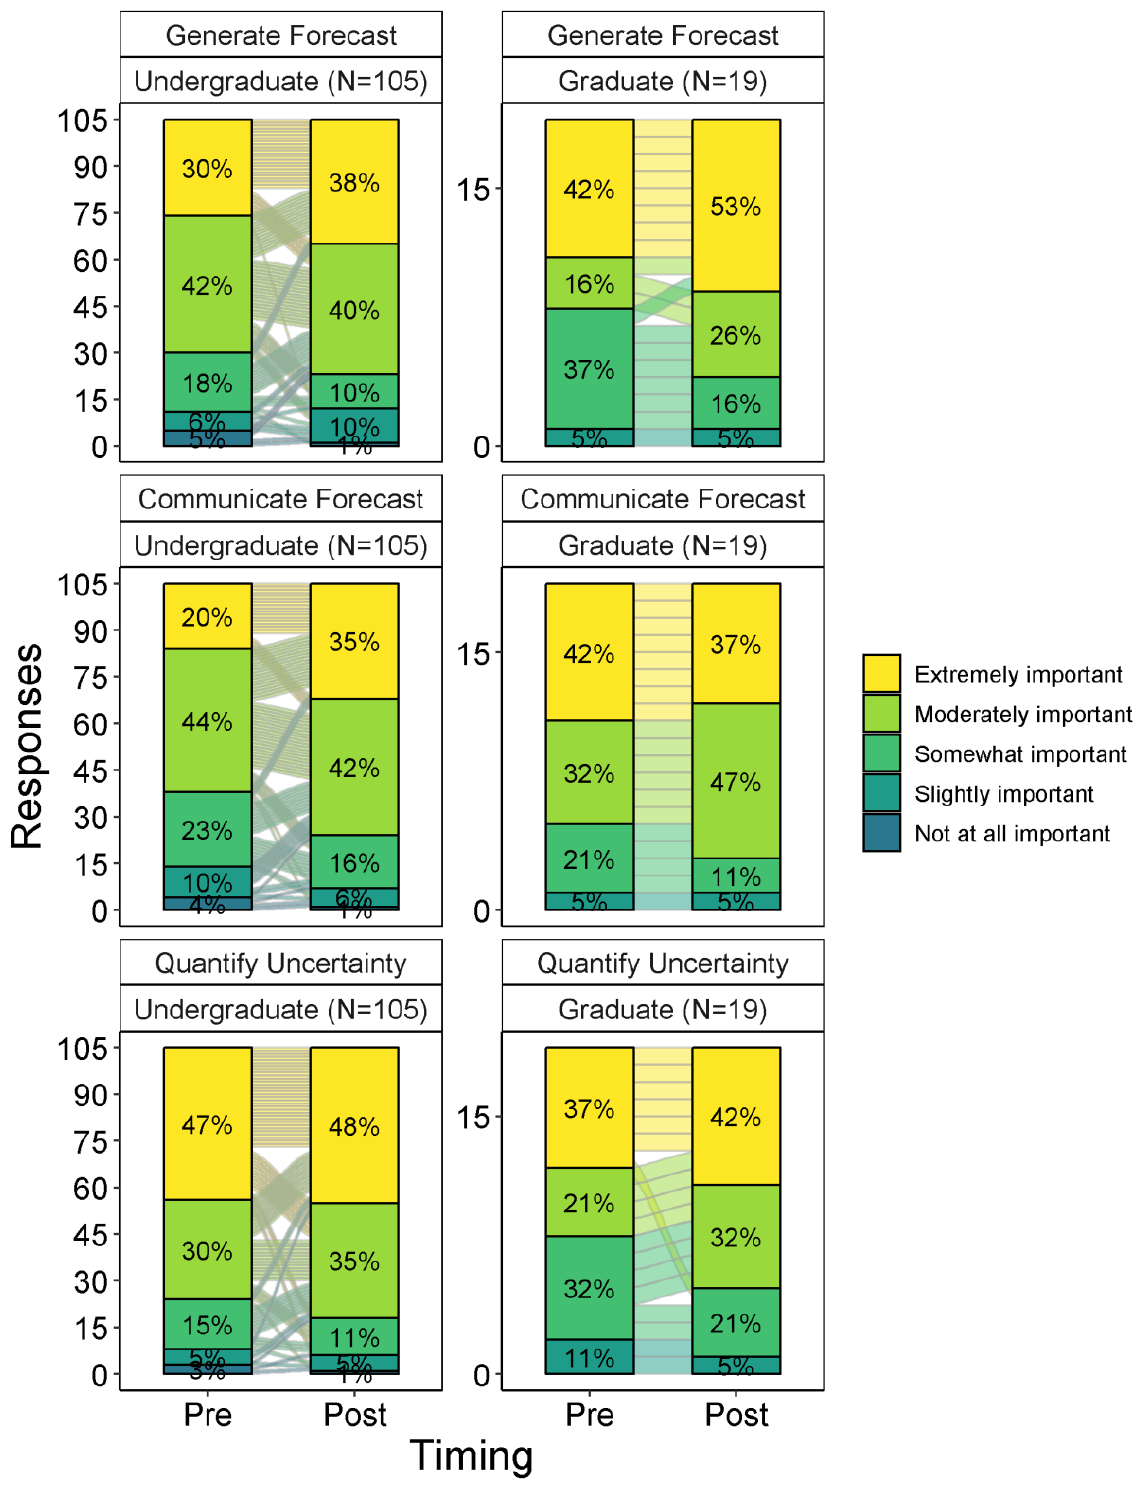
Figure 7. Students’ self-reported assessment of the importance of generating a forecast (left column), communicating a forecast (middle column), and quantifying uncertainty (right column), separated by undergraduate (n = 105, top row) and graduate students (n = 19, bottom row) for the pre- and post-module assessment. Lines between bars represent changes in individual responses pre- and post-module use. Statistical results are given in Table A11.